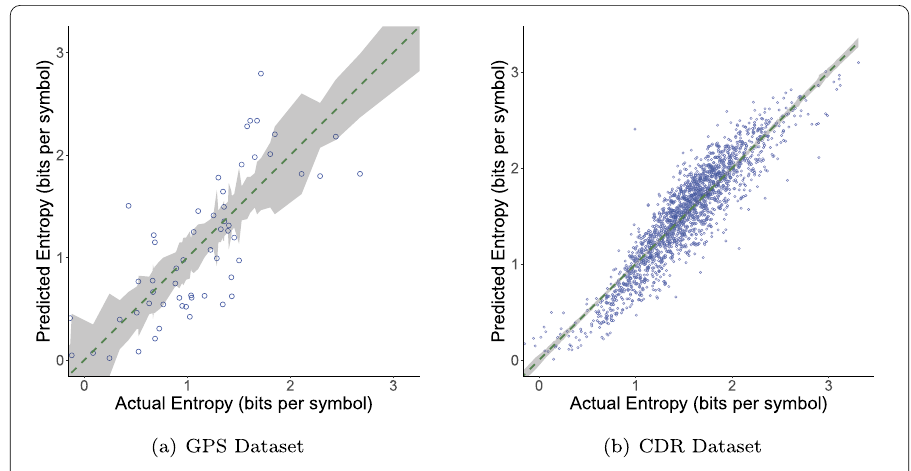
Figure 7 Entropy (in bits per symbol) fitted by the regression model (y-axis) versus actual entropy (x-axis), for both datasets in the next-place prediction problem. The green, dashed line shows the regression